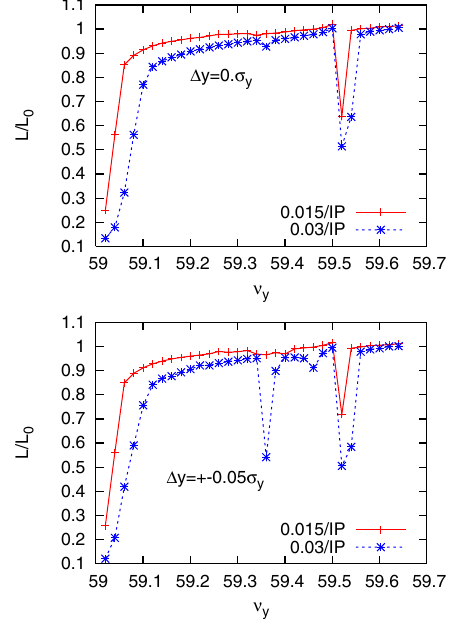
59 59.1 59.2 59.3 59.4 59.5 59.6 59.7